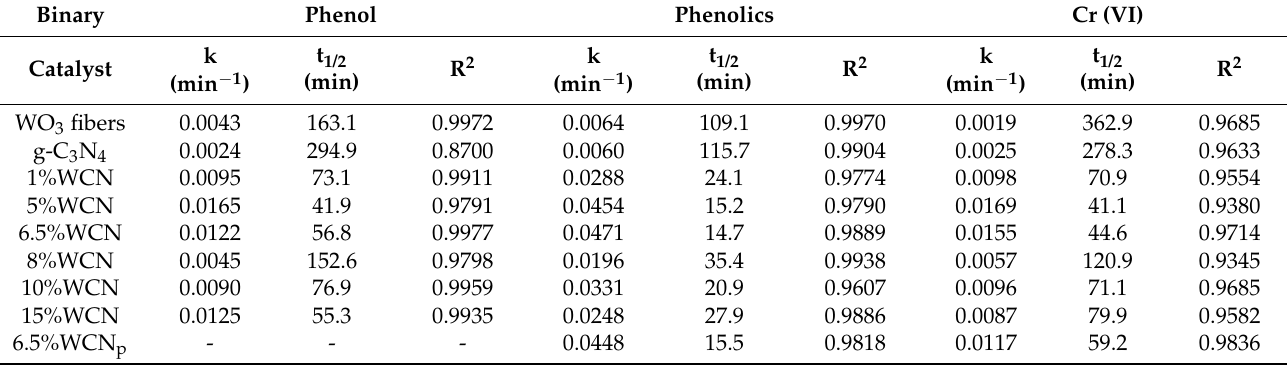
Table 3. Photocatalytic degradation kinetics (k, min − 1 ; t 1/2 , min; R 2 ) of phenol, phenolics and Cr (VI) in binary system. Binary Phenol Phenolics Cr (VI)